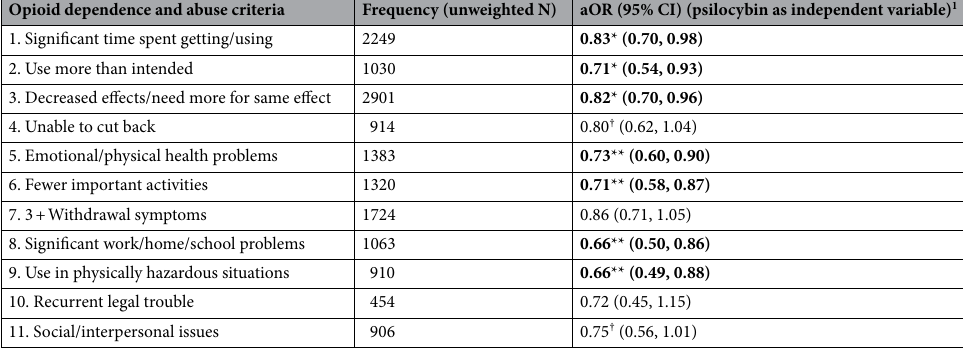
Table 3. Associations between psilocybin and the 11 DSM-IV criteria for opioid dependence and abuse. 1† p < 0.10; *p < 0.05; **p < 0.01; ***p < 0.001; aOR adjusted odds ratio, CI confidence interval. Significant values that indicate lowered odds of OUD criteria are in